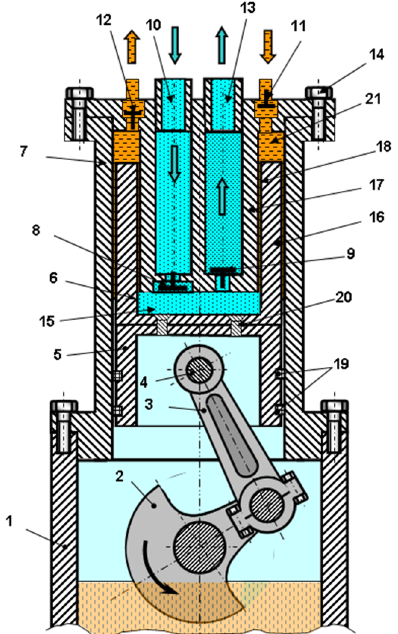
Figure 3. Scheme of longitudinal section of crosshead-free PHPM test model. 1—crankcase; 2—